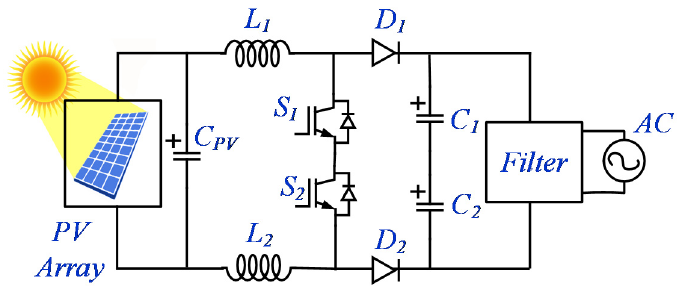
Figure 17. Differential boost inverter .